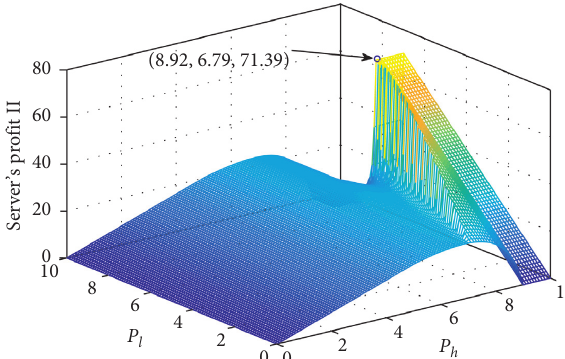
Figure 4: The service provider’s revenue versus the prices p